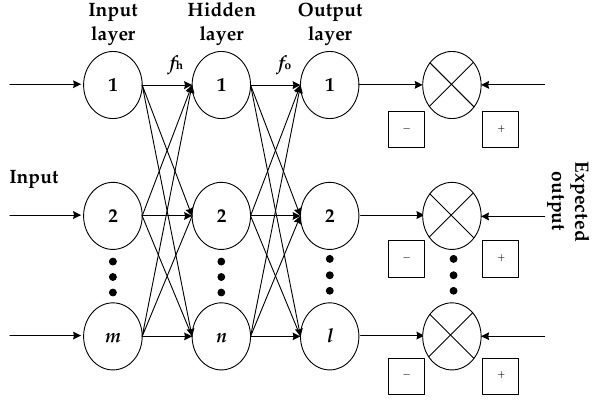
Figure 8. The structure of the BP neural network.